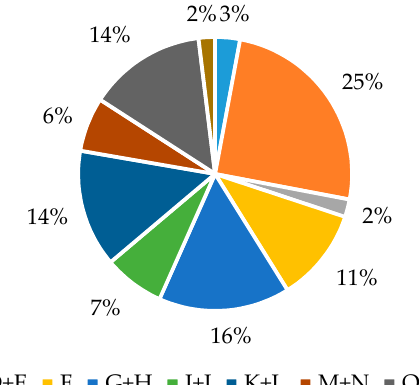
Figure 3. Investments channel during deployment of plants, the structure of total GVA effects per sectors.